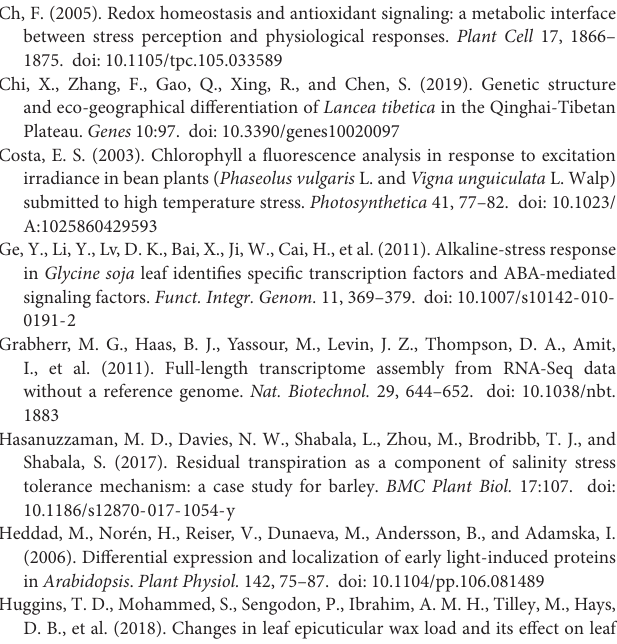
Supplementary Table 8 | Differently expressed genes related to photosynthesis. Supplementary Table 9 | Differently expressed genes related to hormone signal transduction pathway. Supplementary Table 10 | 20 differently expressed genes transcript